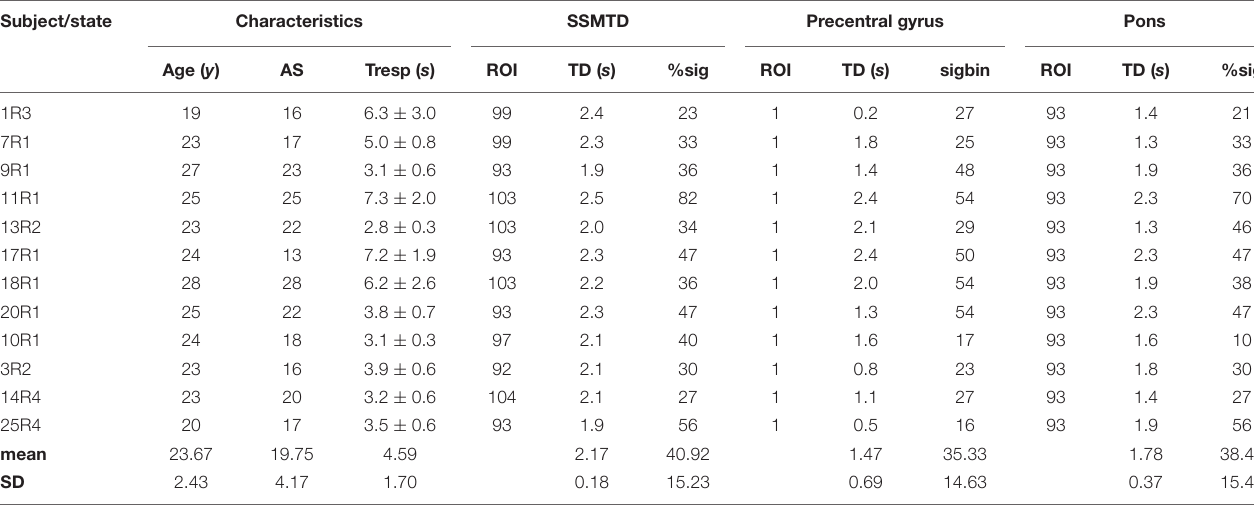
FIGURE 3 | Histograms of TDs averaged over all 4 resting states, plotted separately for the left (A) , and right brain side (B) . Data from 7 ROIs and sigbin ≥ 10% are accumulated. ROIs with odd numbers represent the left, ROIs with even numbers the right brain side. Histograms representing pTDs (between 0.1 and 3 s) are indicated by dark gray color. TABLE 2 | Age (years), state anxiety (AS), breath duration (Tresp [seconds], given as means ± SD), time delay (TD [seconds]) and significant phase coupling (%sig) for ROIs with a subject-specific maximal pTD (SSMTD) in pons/brain stem, ROI 1 (precentral gyrus) and ROI 93 in pons/brain